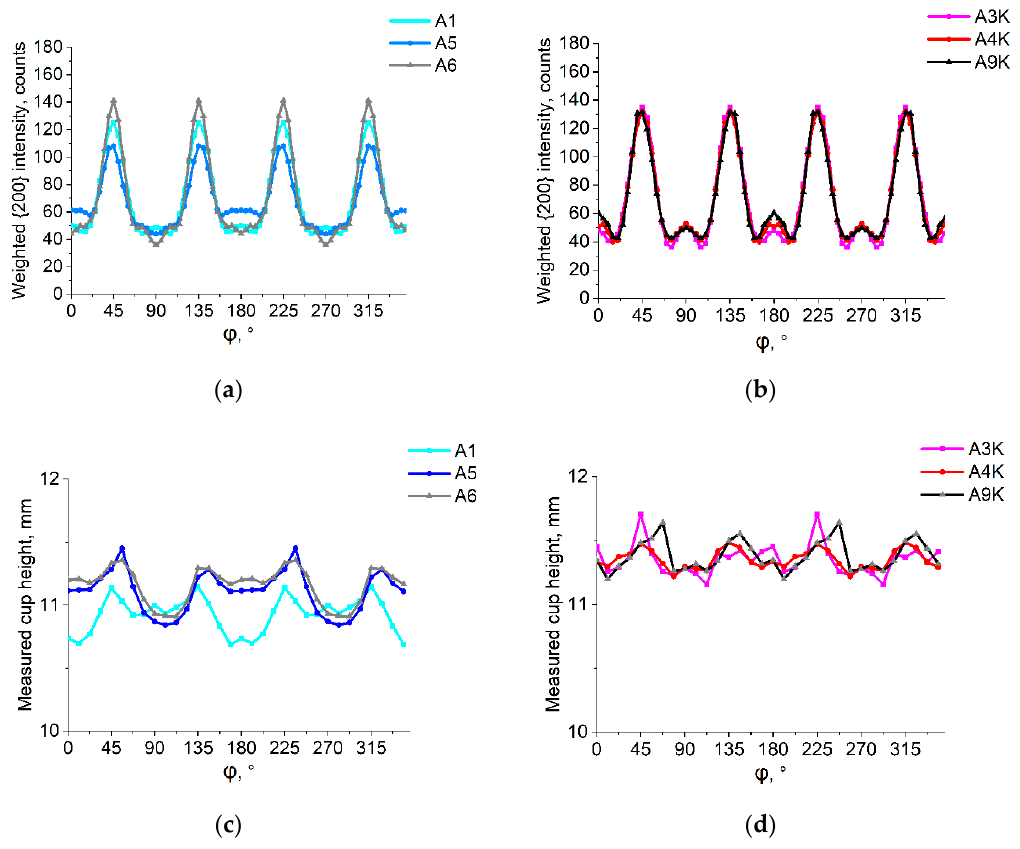
Figure 3. Cup heights of the samples cold-rolled in 6 steps. ( a ) Predicted relative cup heights of unidirectionally rolled samples; ( b ) predicted relative cup heights of cross-rolled samples; ( c ) measured cup heights of unidirectionally rolled samples; ( d ) measured cup heights of cross-rolled samples.